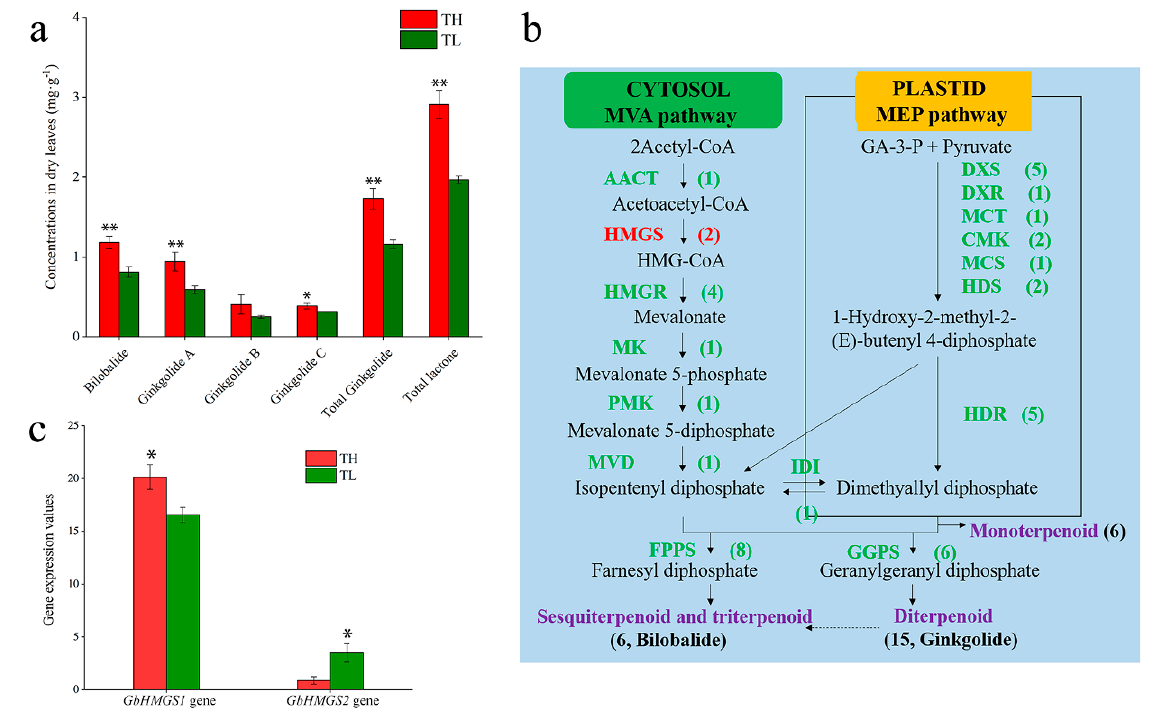
Figure 1. Lactone concentrations and terpenoid biosynthesis pathway in ginkgo leaves: ( a ) Concentrations of lactones in dry leaves. All data were obtained from three biological replicates. The means were compared using Duncan’s multiple range test at P < 0.05 (*) or P < 0.01 (**). The error bars represent the standard deviations of the means; ( b ) MVA and MEP pathways for terpenoid biosynthesis in ginkgo determined by RNA-Seq. The enzymes are shown in green, with the exception of HMGS (red color, differentially expressed mRNA). The substrates and intermediates are shown in black, and the end products are shown in purple. The pathways that occur inside mitochondria and plastids are boxed. The arrows between the cytosol and plastid compartments represent the metabolic flow between these compartments. AACT, acetoacetyl-CoA thiolase; HMGS, 3-hydroxy-3-methylglutaryl CoA synthase; HMGR, 3-hydroxy-3-methylglutaryl CoA reductase; MK, mevalonate kinase; PMK, 5-phosphomevalonate kinase; MVD, 5-diphosphomevalonate decarboxylase; DXS, 1-deoxy-D-xylulose 5-phosphate synthase; DXR, 1-deoxy-D-xylulose 5-phosphate reductoisomerase; MCT, 2-C-methyl-D-erythritol 4-phosphate cytidyltransferase; CMK, 4-(cytidine 5’-diphospho)-2-C-methyl-D-erythritol kinase; HDS, 1-hydroxy-2-methyl-2-butenyl 4-diphosphate synthase; HDR, 1-hydroxy-2-methyl-2-butenyl 4-diphosphate reductase;